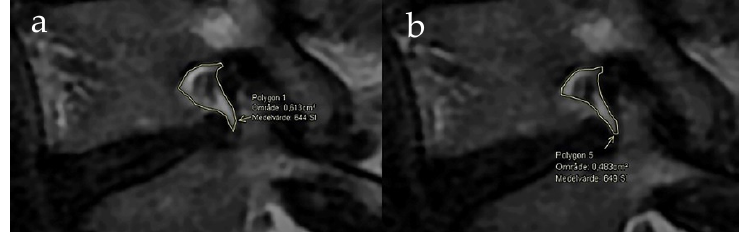
Figure 2. MRI of a right L4–5 foramina without loading of the spine ( a ) and MRI of the same foramina acquired with axial loading ( b ). The measurement area is marked in both images and a reduction in the area was measured. The fat surrounding the nerve root is visually reduced in the MRI with loading.